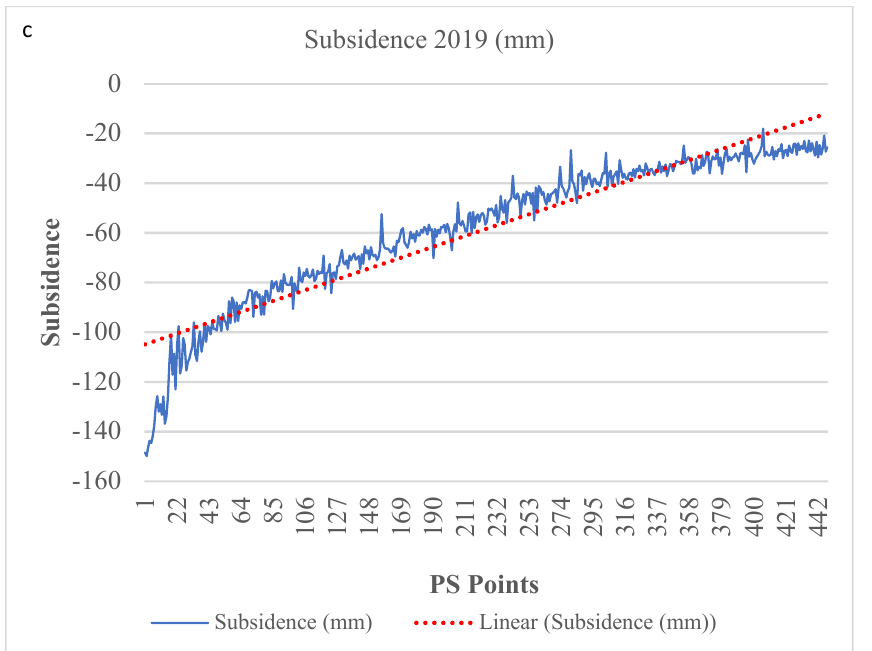
Figure 8. Subsidence fluctuation graphs; ( a ) 2017, ( b ) 2018, and ( c ) 2019. Figure 8a shows the ground subsidence in 2017. Figure 8b shows the ground subsidence in 2018. Figure 8c shows the ground subsidence in 2019. The x-axis in the figure represent PS points in the study area, while the y-axis represents the subsidence. In the study area, five PS points (P1, P2, P3, P4, and P5) from the subsidence area were selected within the descending and ascending results (Figure 9a,b). Here, the PS points highlight the relative movement and stability (red = high, blue = stable, yellow/light green = low) compared to the surroundings. Analyses of the subsidence along these five PS points are shown in Figure 10. The subsidence area is shown with red dots in (Figure 9a,b). The obtained results highlight variations in the ground subsidence from place to place during the analysis pe- riods. The subsidence along these points (P1, P2, P3, P4, and P5) are plotted in Figure 10. Here, P1 lies on southernmost part of the study area where subsidence reached − 104.4